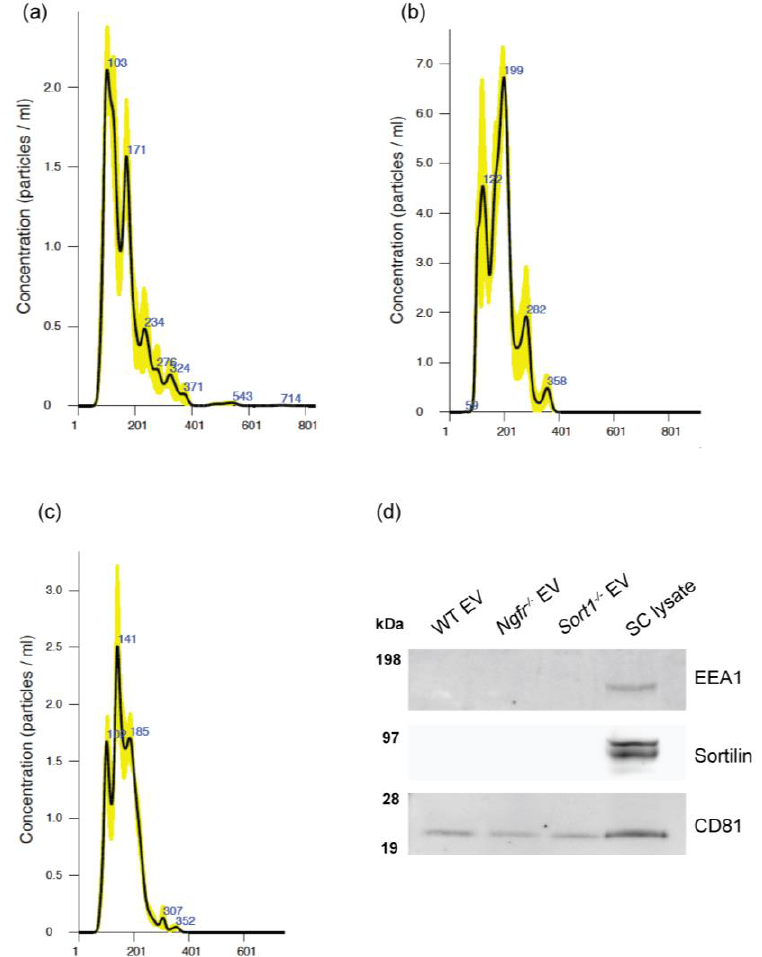
Figure 2. Size distribution of vesicles secreted by the primary Schwann cells (SCs). Representative plots with nanoparticle tracking analysis results of extracellular vesicles (EVs) collected from 3 × T175 flasks from ( a ) WT, ( b ) Sort1 − / − and ( c ) Ngfr − / − derived rat primary SCs. ( d ) Immunoblot showing CD81 expression in both the EV pellets and SC lysate, while EEA1 and sortilin were only found present in the SC lysate.